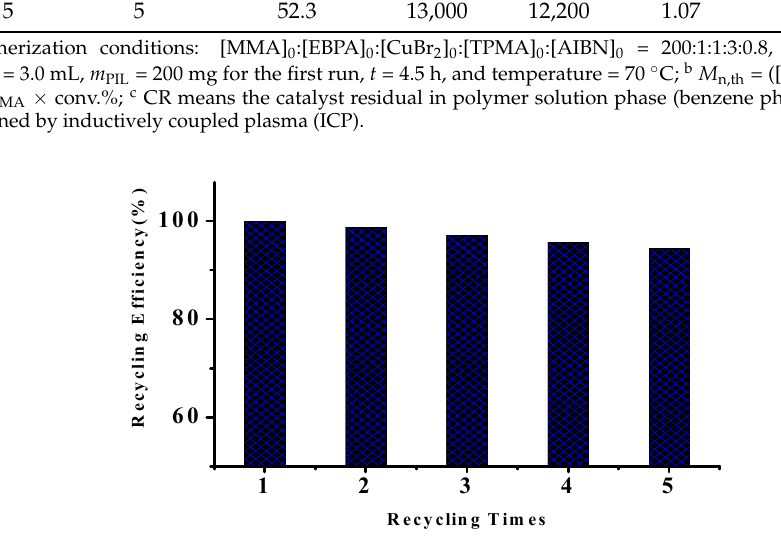
Figure 6. Recycling efficiency as a function of recycling times. Polymerization conditions: m PIL = 200 mg, t = 4.5 h, and temperature = 70 ◦ C. Recycling efficiency was calculated by the percentage of residual copper catalyst in poly(ionic liquid) phase to the original copper catalyst, which was determined by ICP.